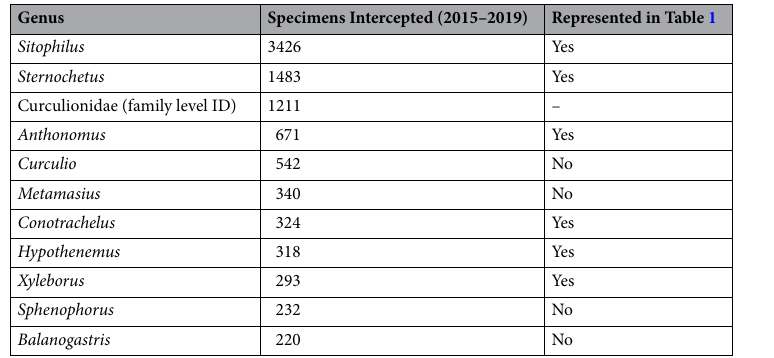
Table 4. Frequently intercepted Curculionidae genera